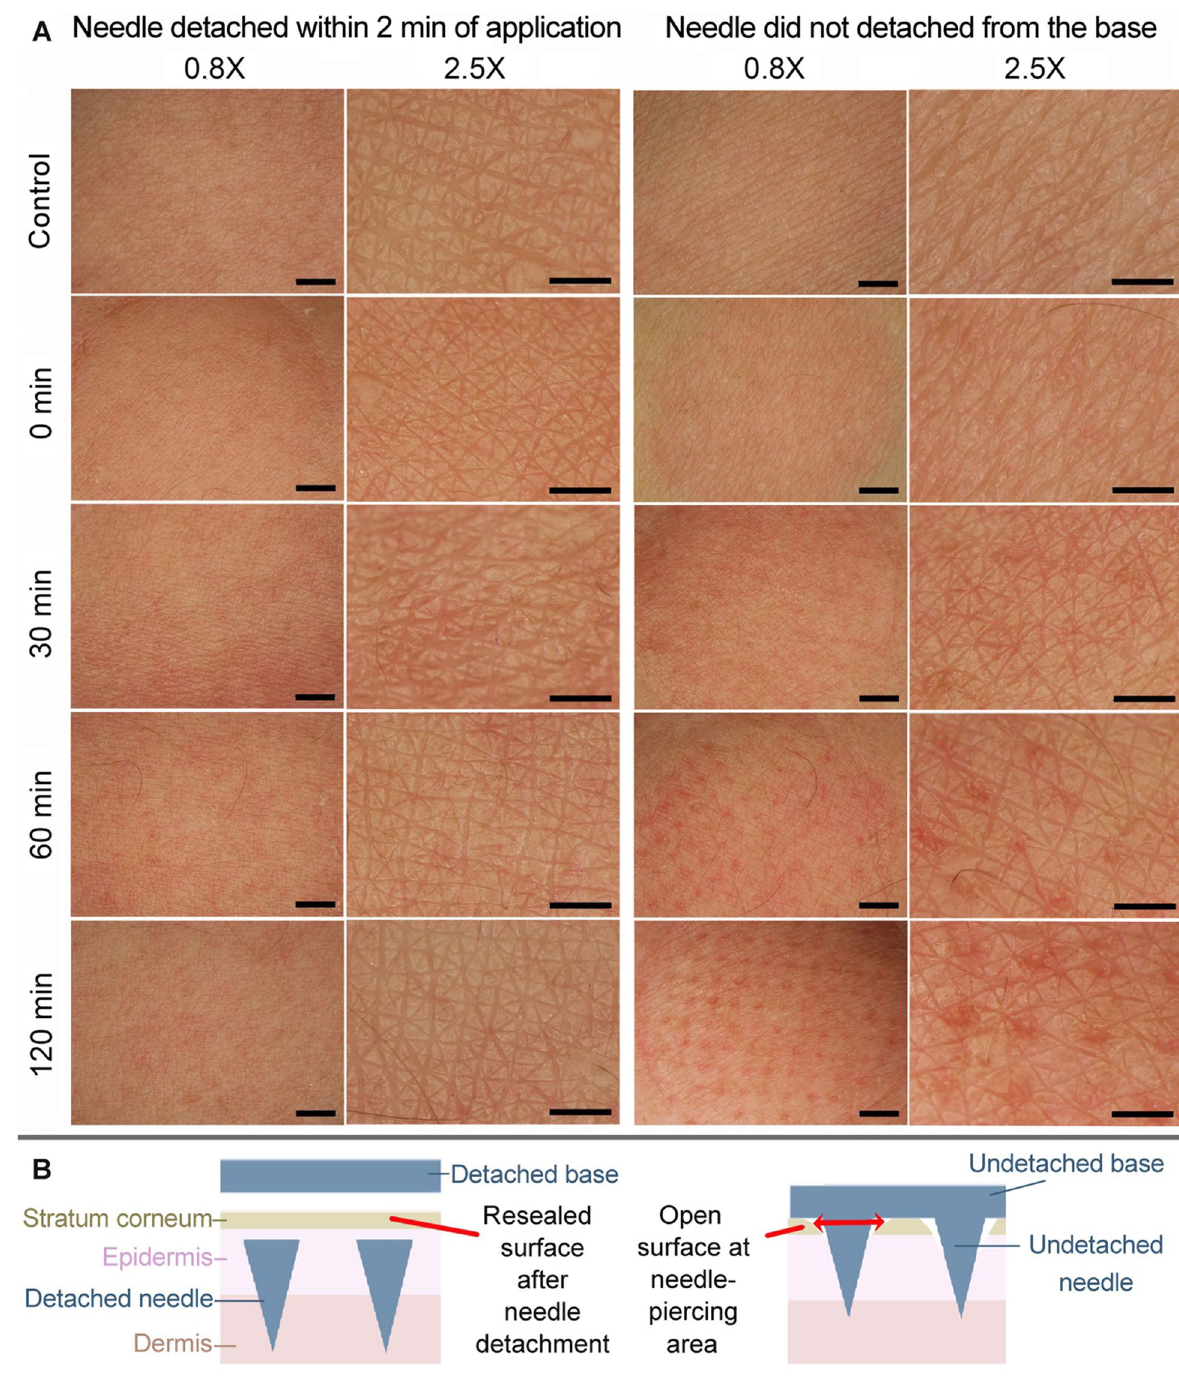
Figure 4. Skin surface conditions after microneedle administration. ( A ) Photographs at 0.8× (first and third columns from the left) and 2.5× (second and fourth columns from the left) magnifications of a human volunteer inner forearm skin after the application of the two types of 350 μm microneedles, the needle-detaching type and the non-detaching type. For the DDMN or the needle-detaching type , the skin was applied with the low dose- vitC-gluta-350-DDMNs (the needles were detached, and the base removed, at 2 min after the administration), then the skin was photographed at various times post the administration (see the denoted times on the left of each row). For conventional microneedles or the DMN with no needle detaching feature, the skin was applied with the 350 μm DMN patch (same morphology as the DDMNs) and the patch was left on the skin for 0, 30, 60 and 120 min (time denoted on the left of each row), then the patch was removed, and the skin was photographed immediately. Control is the image of the untreated skin. Scale bars on images in the first and the third columns from the left represent 2 mm, and in the second and the fourth columns represent 1 mm. ( B ) Illustration showing how needle detachment allows for skin surface resealing (Left), and how the un-detachment of needles creates skin channels at each needle penetration site